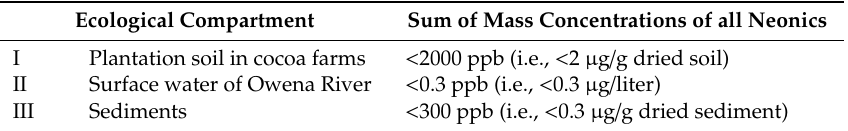
Table 7. Upper limits of neonic concentrations in compartments of the Owena River Basin. Ecological